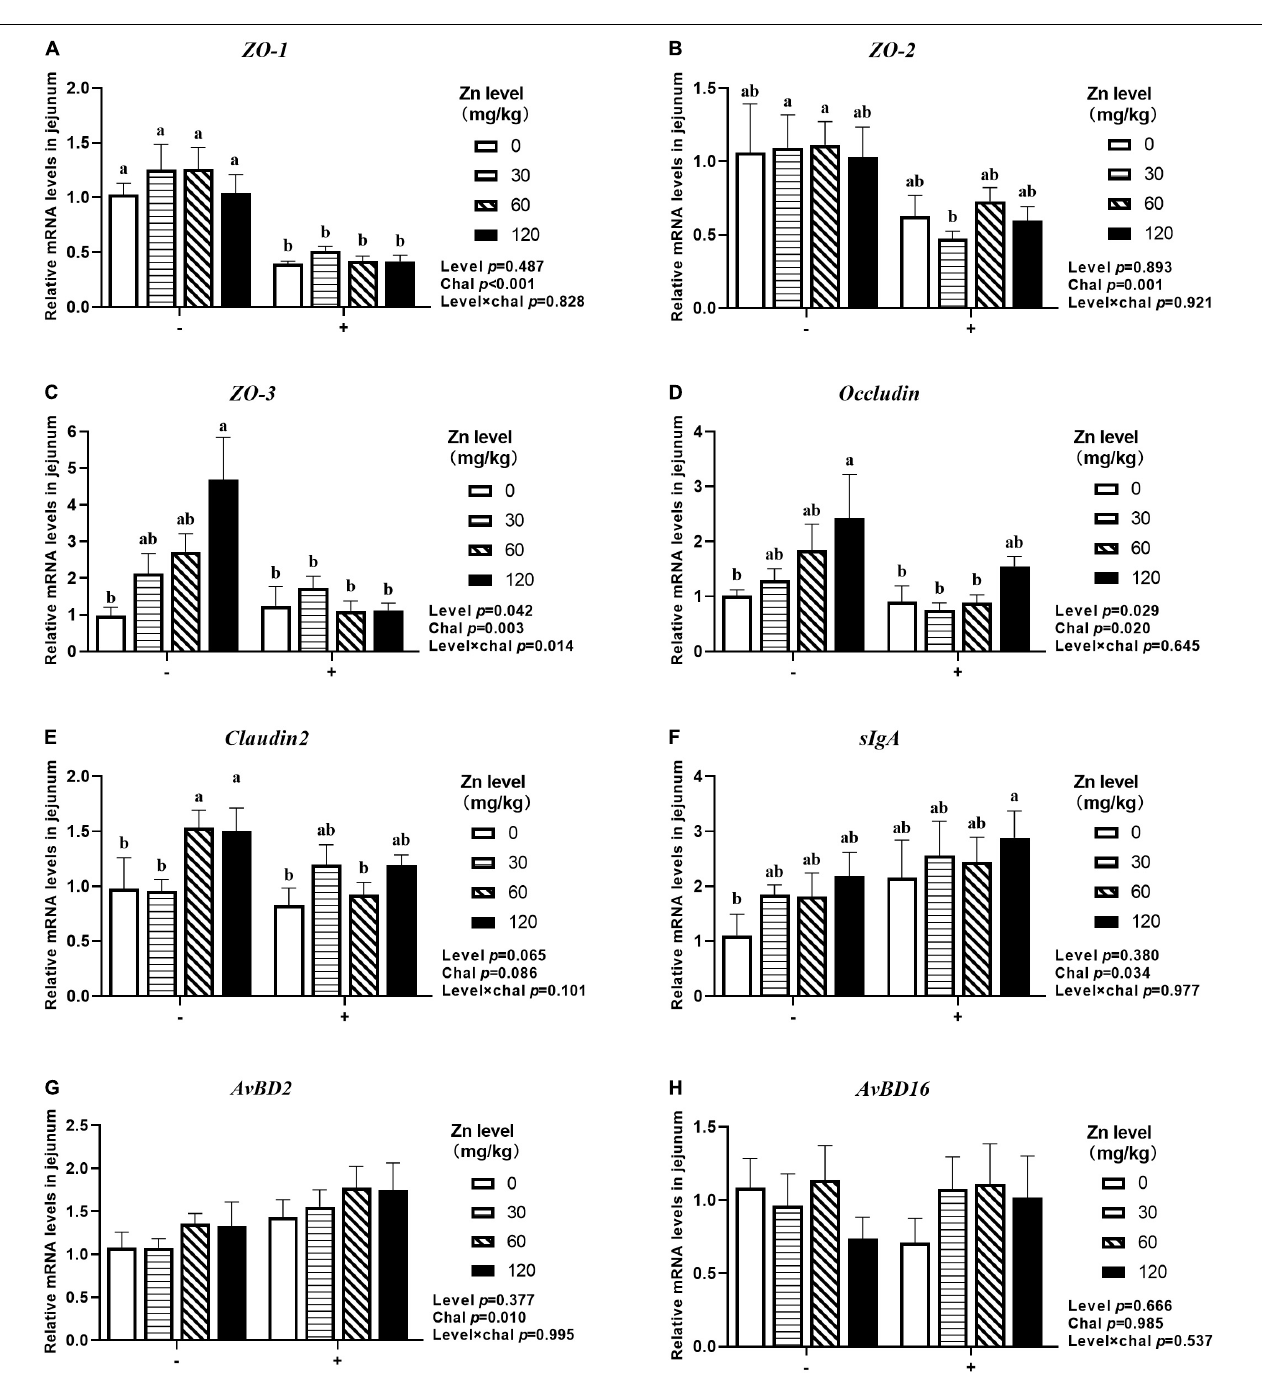
FIGURE 7 | Effect of dietary Zn–Met levels on the mRNA expression of barrier-related gene ZO-1 (A) , ZO-2 (B) , ZO-3 (C) , Occludin (D) , Claudin2 (E) , sIgA (F) , AvBD2 (G) and AvBD16 (H) in jejunum of meat duck challenged with APEC (2 DPI). Bars with different letters are statistically significant ( P < 0.05). Results are expressed as mean ± SEM ( n =